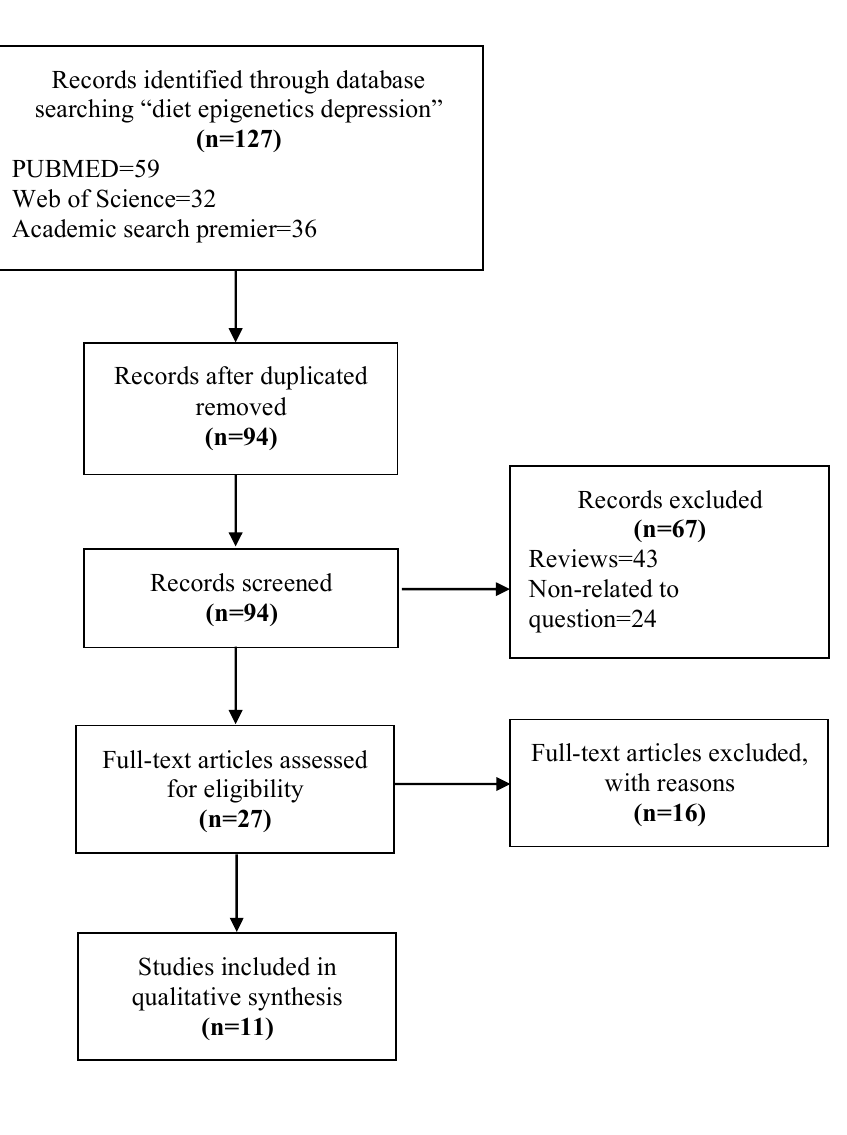
Figure 1. PRISMA flow diagram followed to get to the final selection of studies included in the review.